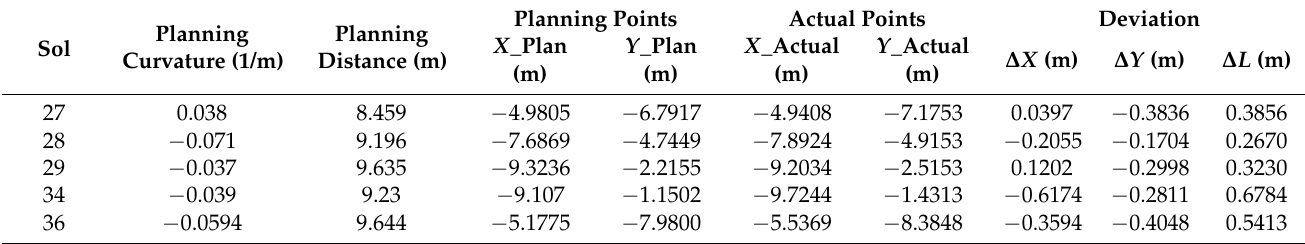
Table 4. Planning end points and actual end points of arrival.